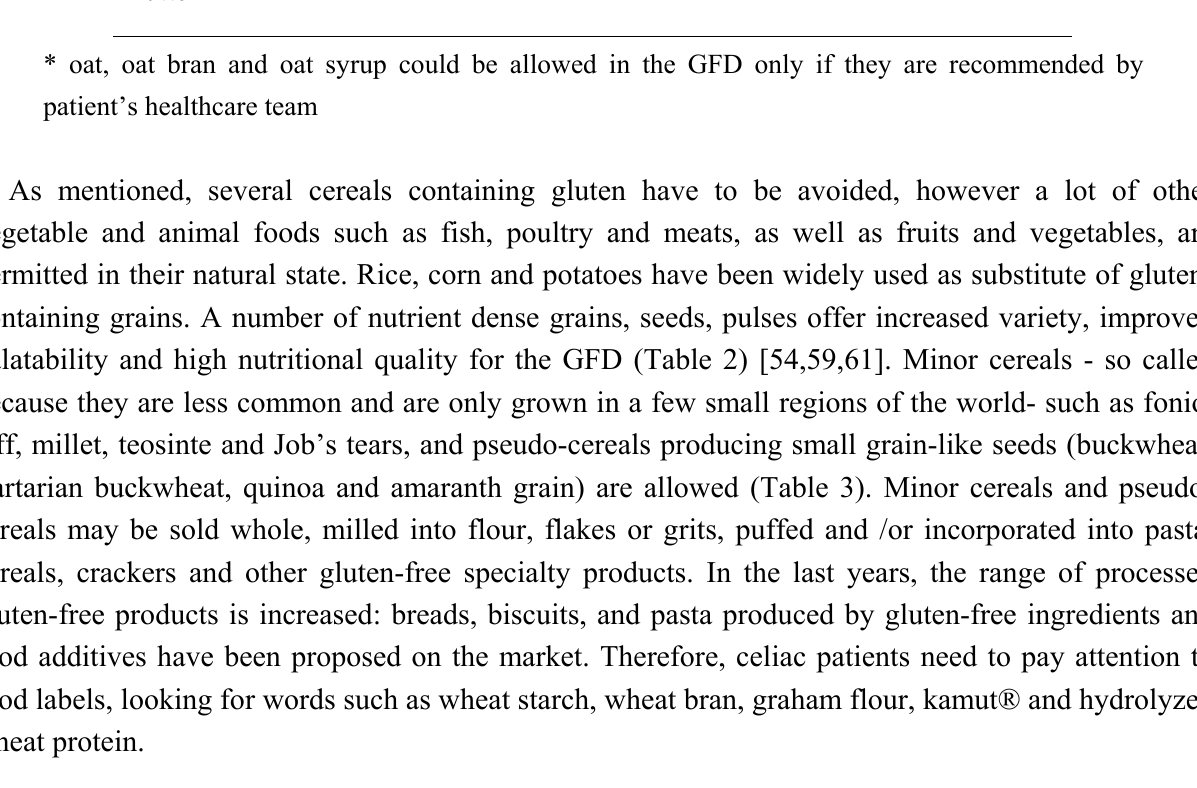
Table 3. Characteristics of some plant (pseudo-cereals and minor cereals) gluten-free alternative.